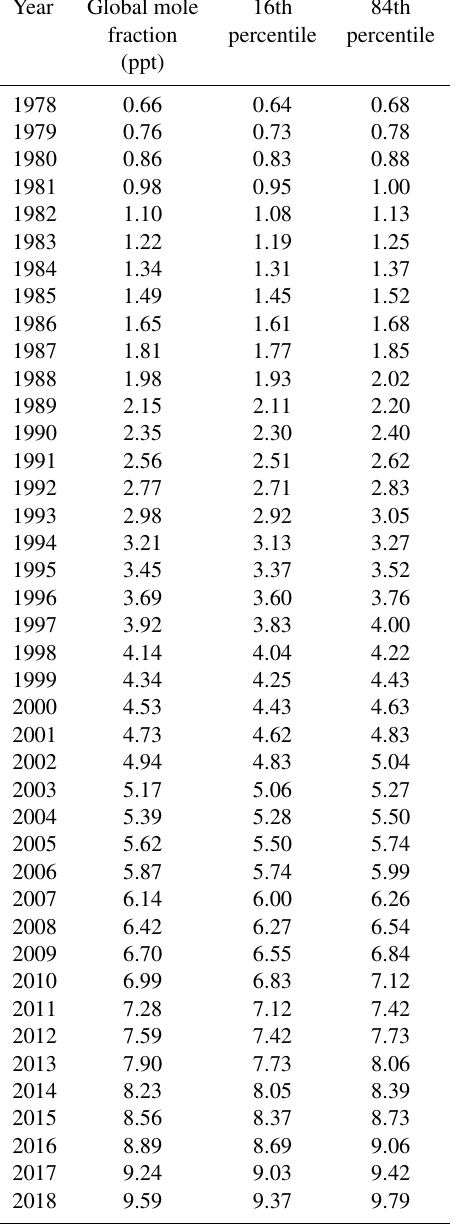
Table 4. Global SF 6 mole fraction output from the AGAGE 12-box model.